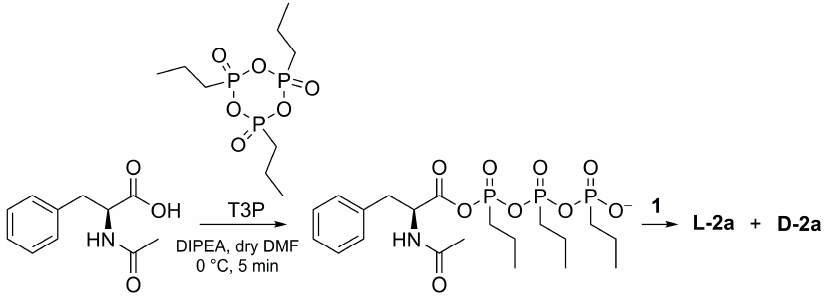
Figure 6. Synthesis of L-2a in coupling mediated by T3P. The activation of N-Ac- L -phe starts with the deprotonation of the carboxylic acid and continues with the attack of electrophile cyclic phosphonic anhydride.